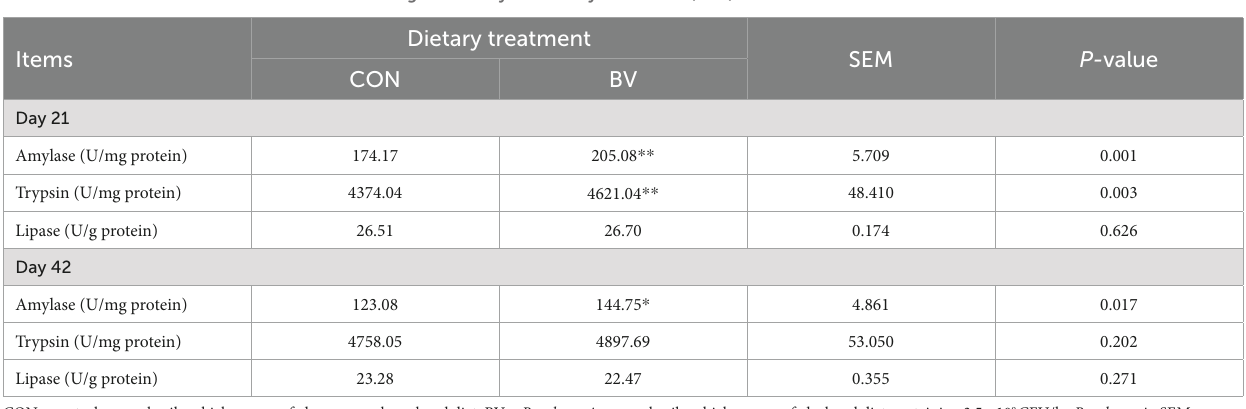
TABLE 4 Effect of Bacillus velezensis LB-Y-1 on digestive enzyme activity of broilers ( n = 6).